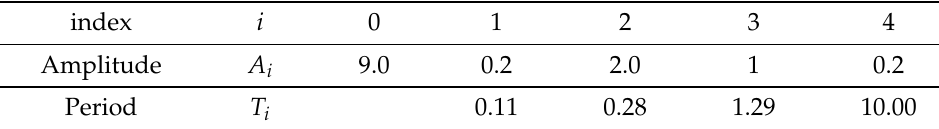
Table 3. Values of the parameters for the wind